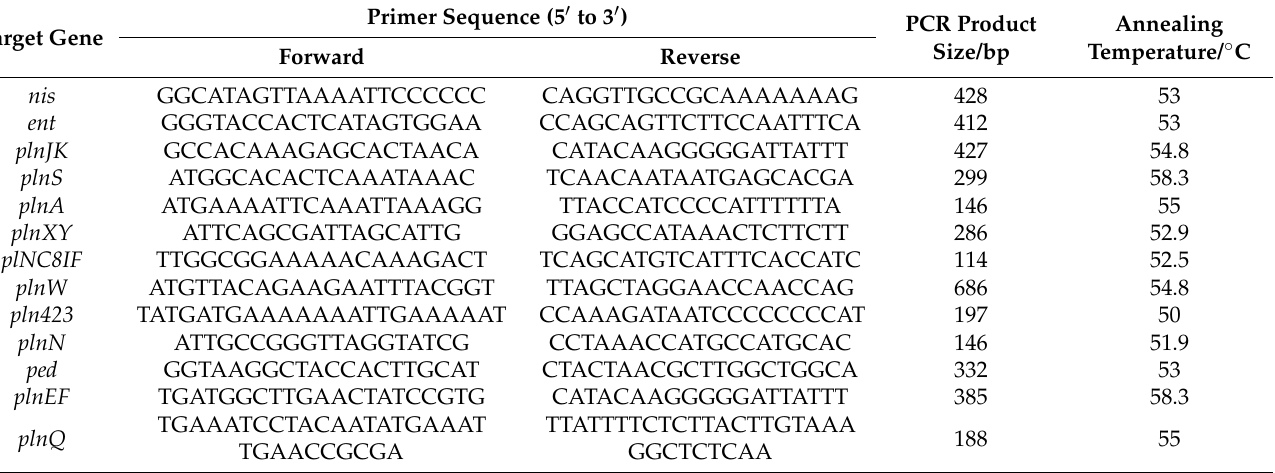
Table 1. PCR primers for LAB bacteriocin-producing